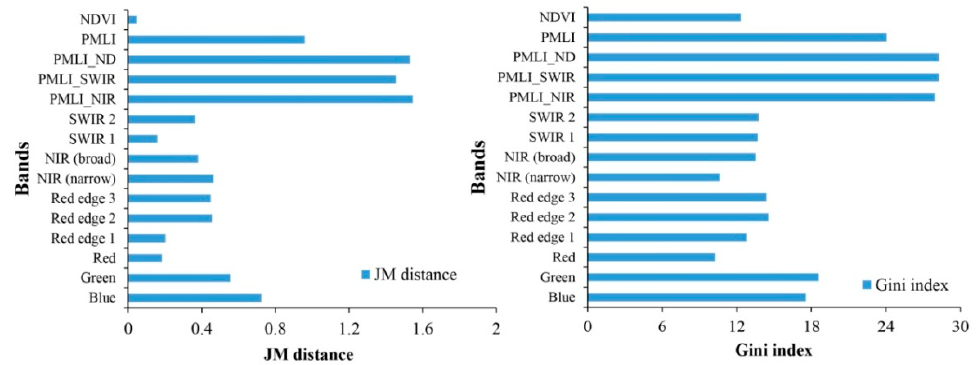
Figure 6. Feature separability and importance. ( a ) Jeffries–Matusita (JM) distance, ( b ) Gini importance score.